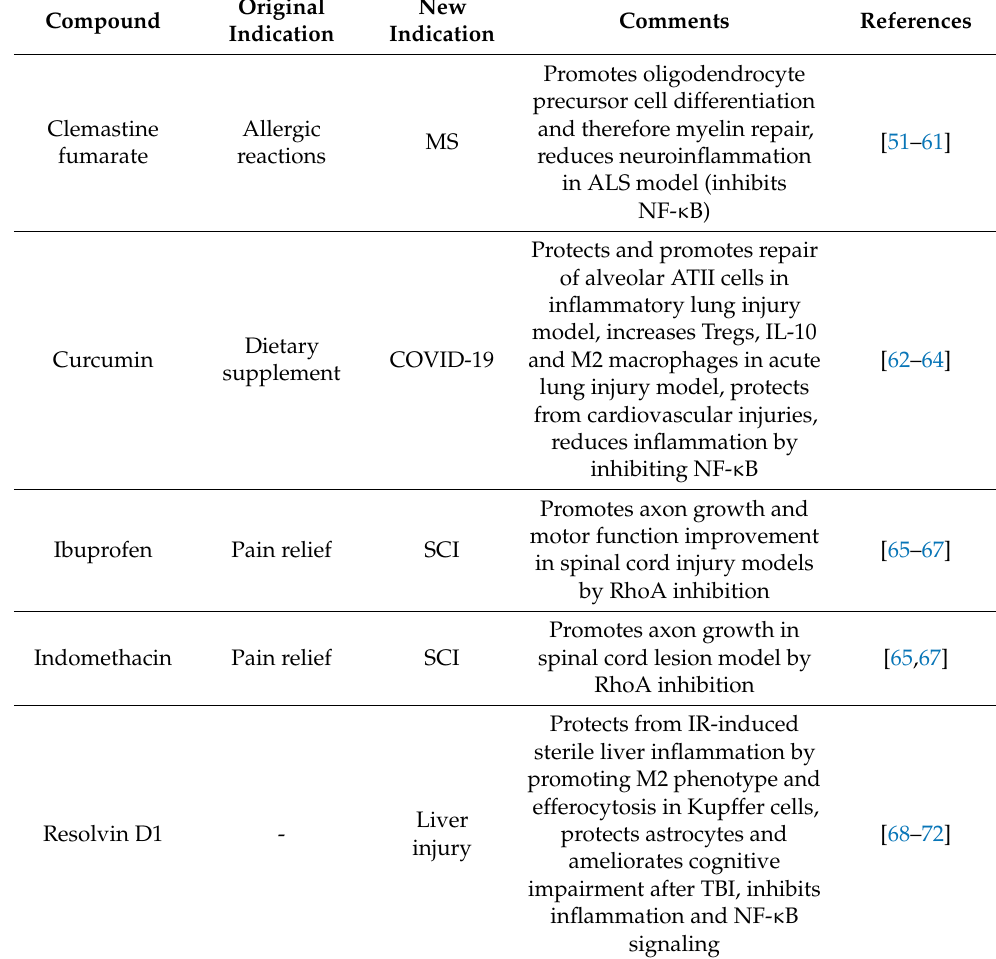
Table 2. Compounds with reported anti-inflammatory and prorepair properties. Few compounds have been reported that both inhibit inflammation and promote repair processes. While some have been investigated in clinical trials, none have received FDA-approval: SCI = spinal cord injury; IR = ischemia/reperfusion; TBI = traumatic brain